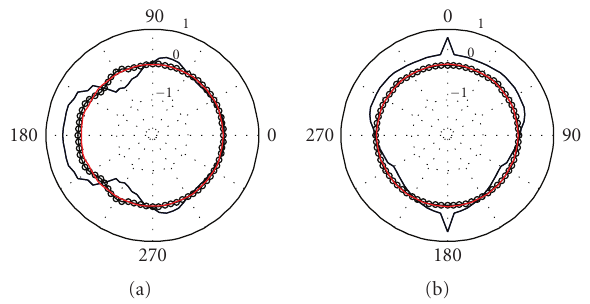
Figure 20: (a) SNRD (dB) in azimuth and (b) elevation plane. d = 5cm (black line), 10 cm (open dots), and 20 cm (red